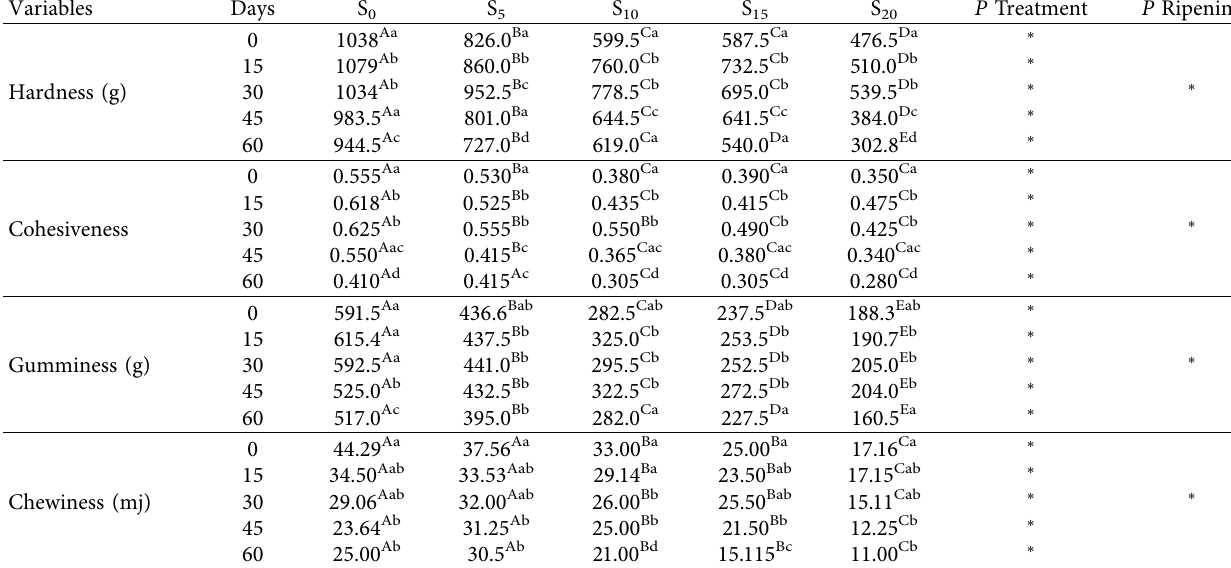
Table 6: The textural properties of Fruit whey less Feta-type cheeses produced using different percentages of pomegranate juice (S S 15 , and S 20 , respectively, containing 0, 5, 10, 15, and 20% of pomegranate juice). Variables